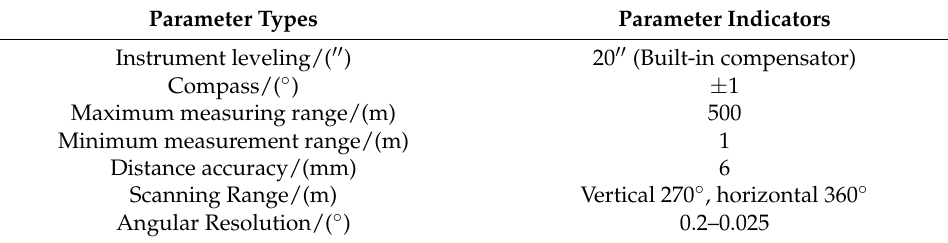
Table 1. Parameters of Maptek I-site 8200ER ground 3D laser